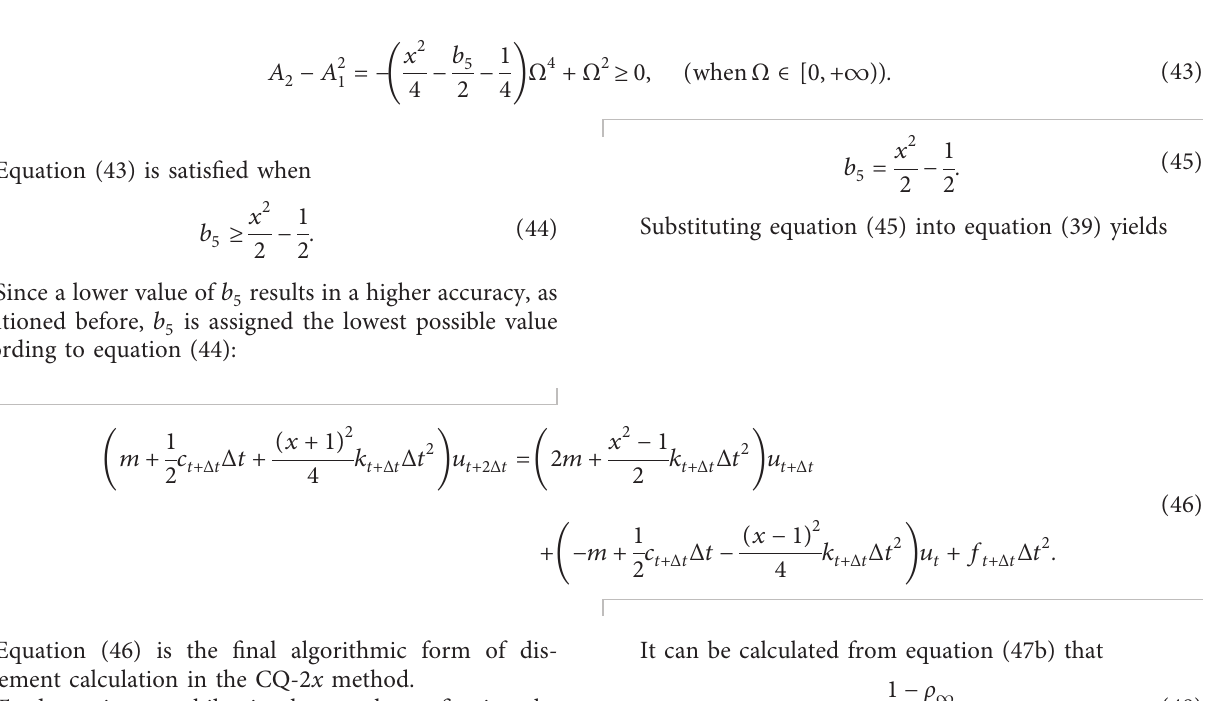
Figure 1: NDA stability domain.